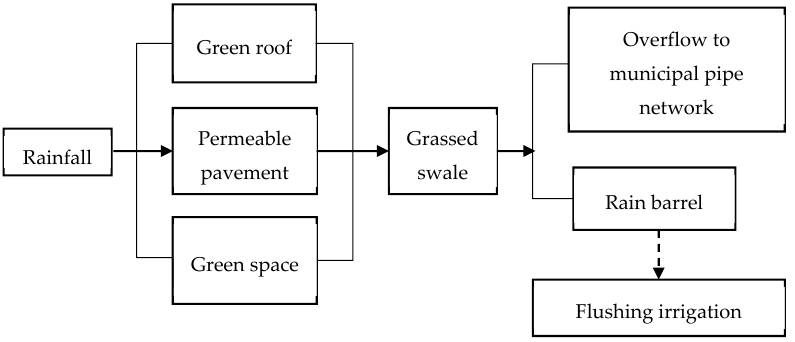
Figure 3. Drainage path of runoff in the LID model.